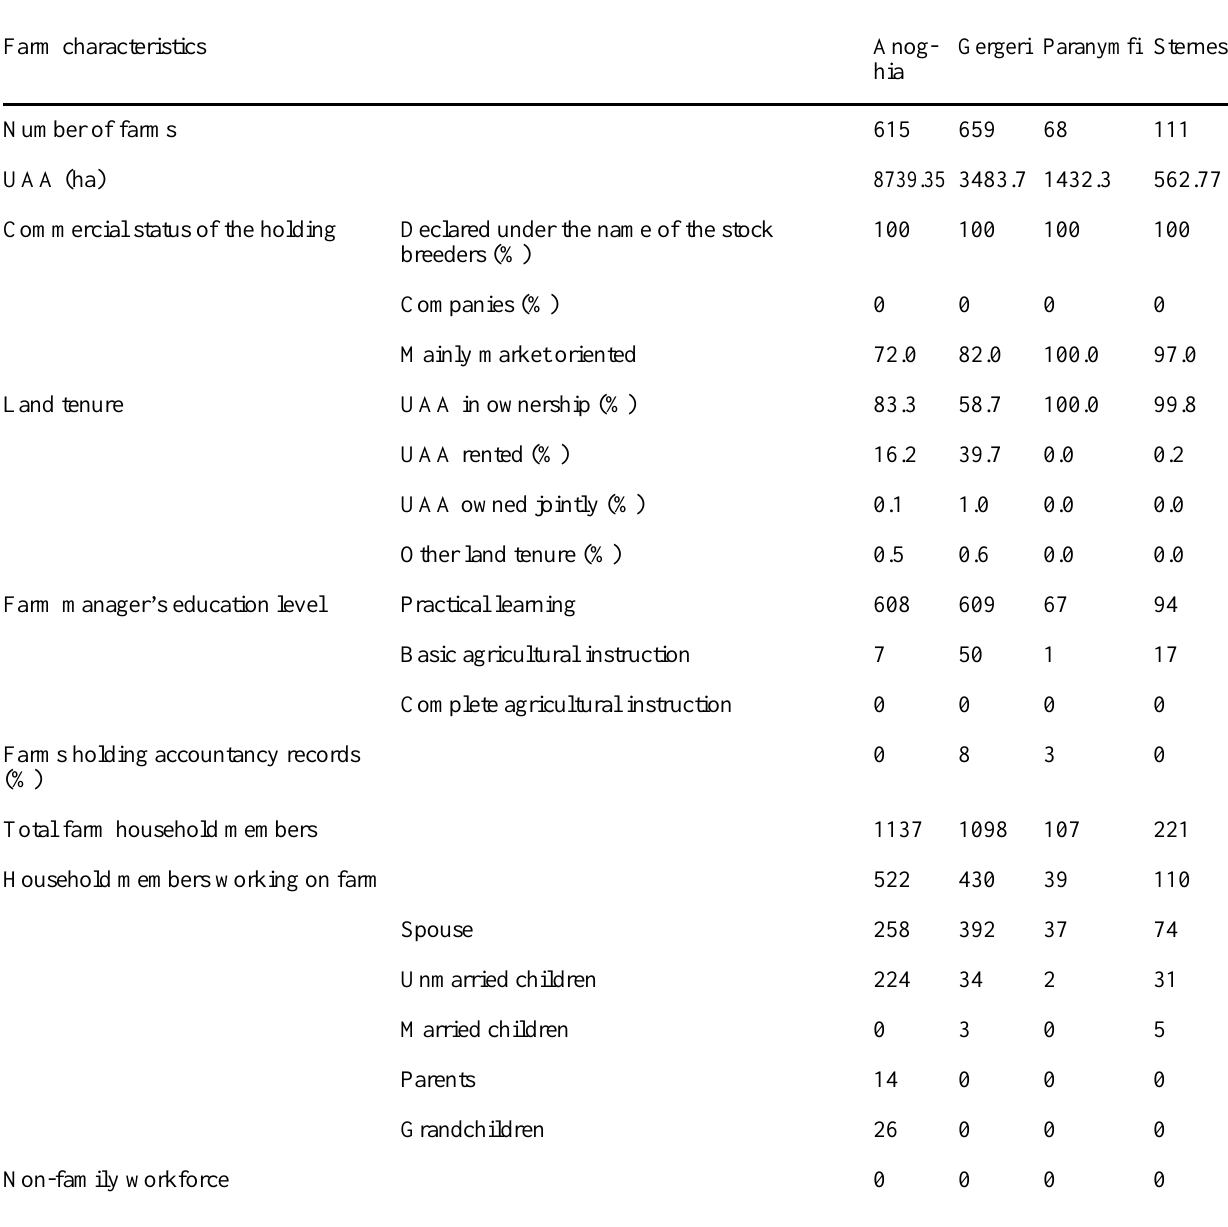
Table 3. Socioeconomic characteristics, land tenure, and household composition of farms from the four village communities in 2000